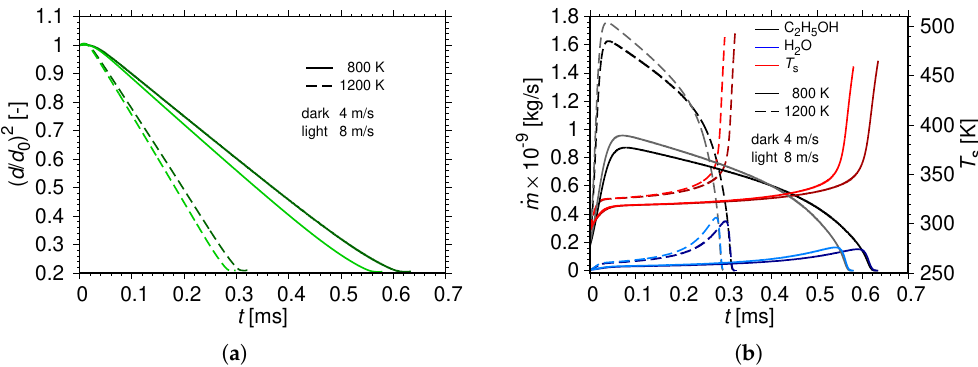
Figure 2. Initial conditions: r d,0 = 5 µ m, T l,0 = 293.15 K, p = 1 bar, u 0 = 4 m/s and 8 m/s, T g,0 = 800 K and 1200 K, Y C = 0.80, Y INN,0 = 0.200. ( a ) Normalized droplet surface area with time. ( b ) Mass 2 H 5 OH,0 evaporation rate and droplet surface temperature with